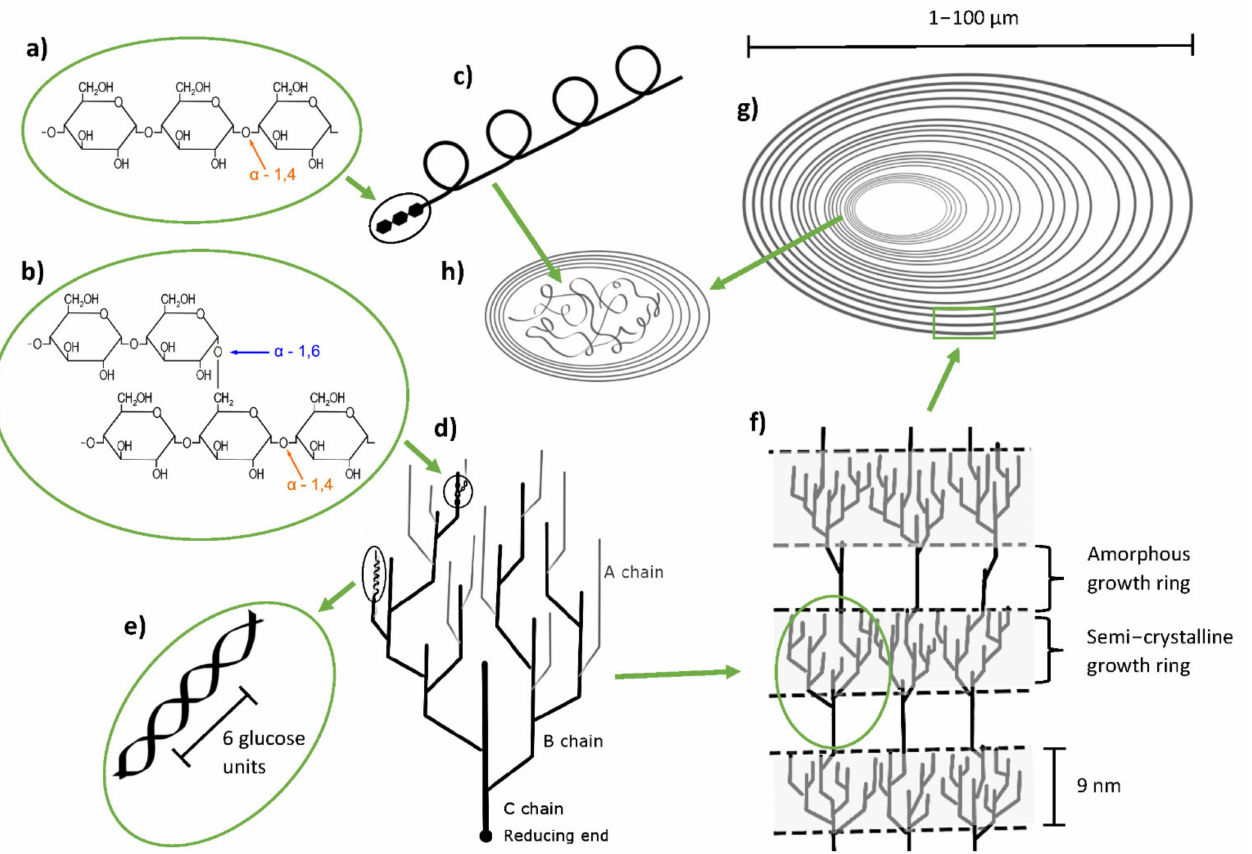
Figure 3. Schematic illustration of some key elements of the macro- and microstructure of potato starch ( a ) molecular structure of amylose, ( b ) molecular structure of amylopectin, ( c ) helical arrange- ment of amylose, ( d ) arrangement of amylopectin, ( e ) double helix structure of neighboring A and B chains, ( f ) cluster model of amylopectin with alternating amorphous and semi-crystalline parts, ( g ) potato starch granule, ( h ) starch hilum containing mainly amylose. (Own illustration, based on references